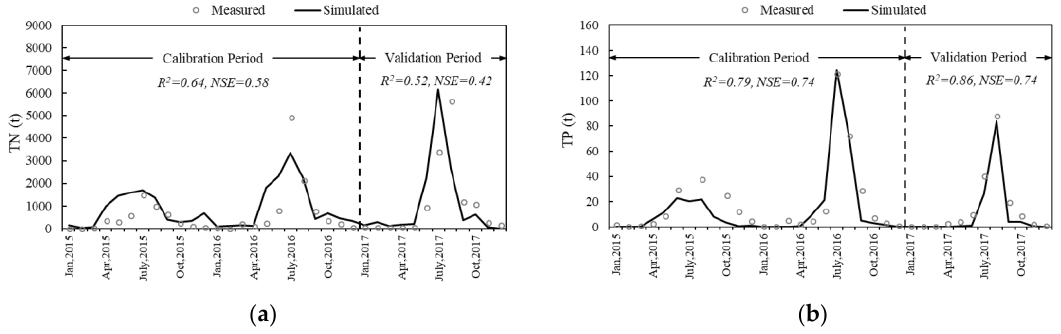
Figure 3. The hydrological calibration and validation results of the Luanxian Station.